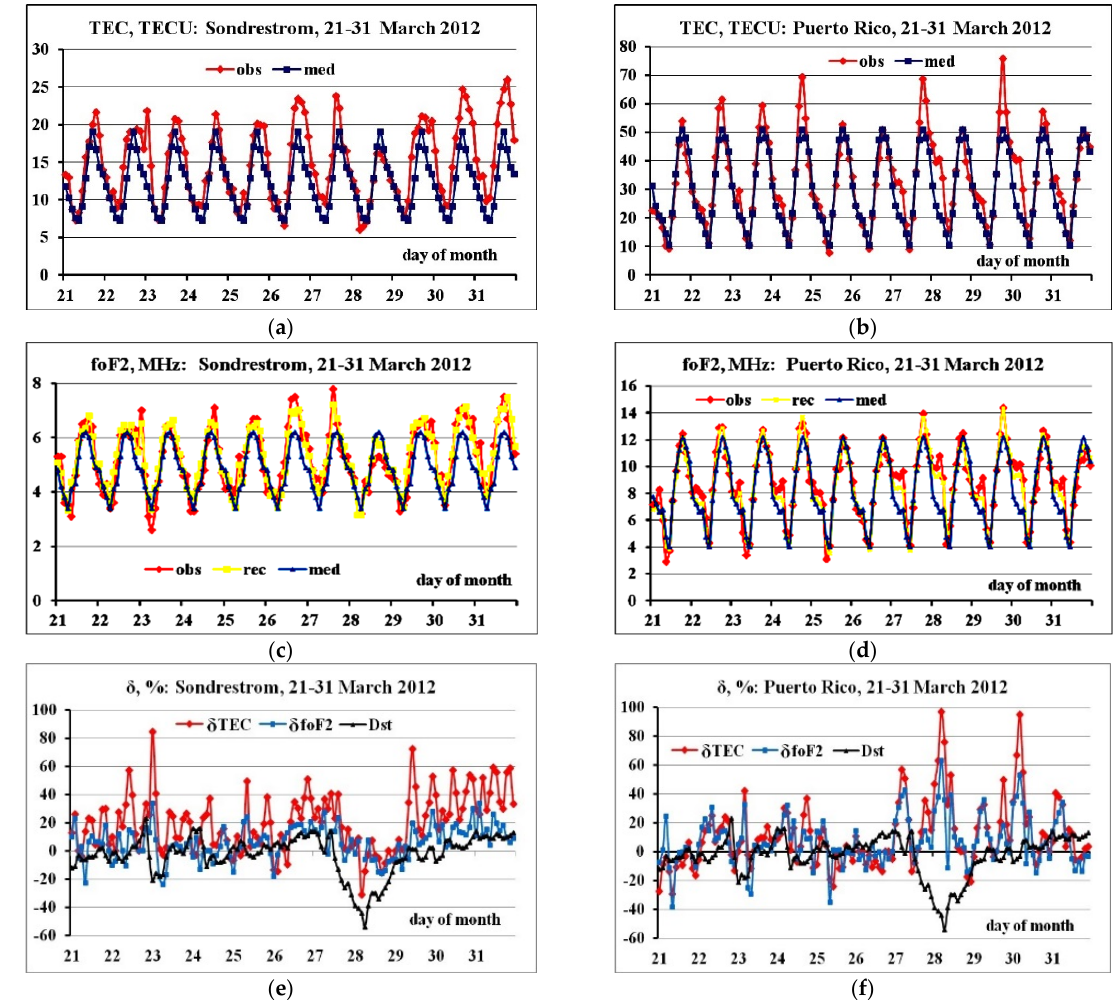
Figure 8. The same as in Figure 7 but during 21–31 March 2012 at Sondrestrom station ( left panels ); Puerto Rico station ( right panels ).